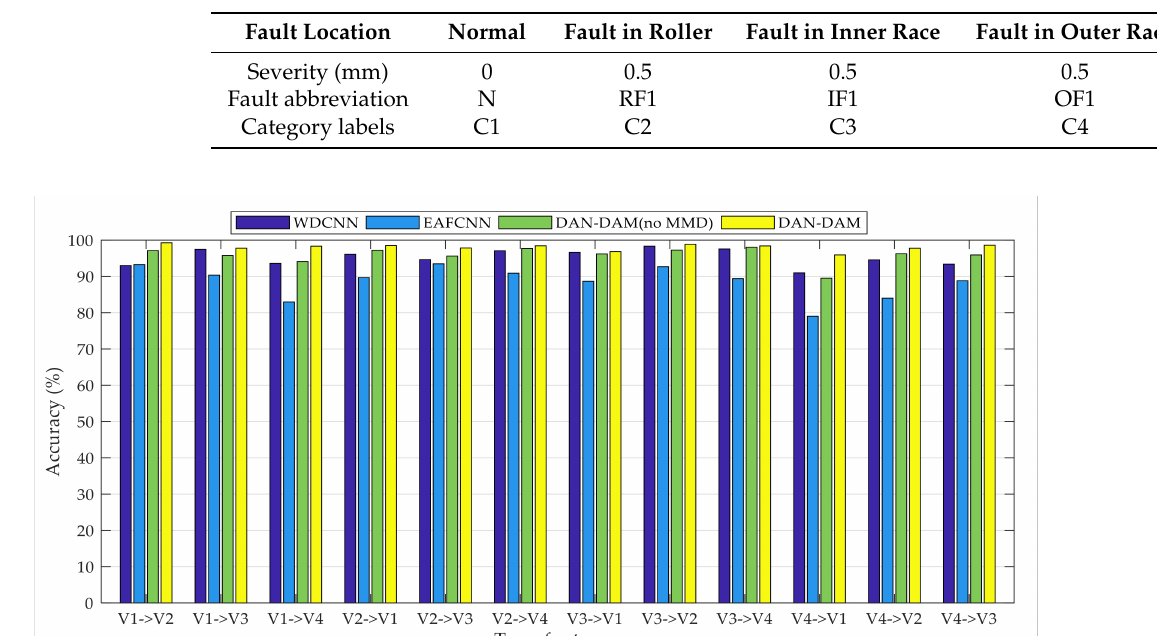
Figure 8. The experiment platform of private datasets. Table 4. Data setting parameters table of private datasets.